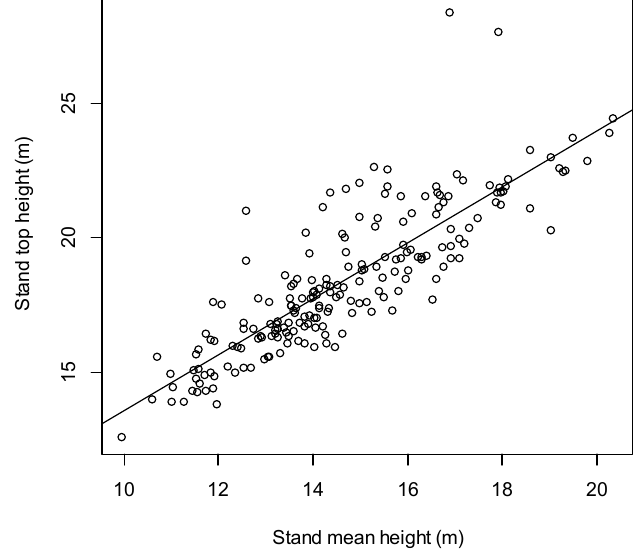
Figure 1. Scatter diagram of stand top height against stand mean height.